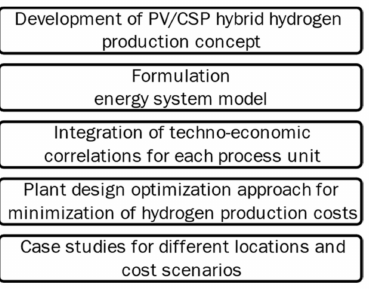
Figure 1. Work flow and main stages of the